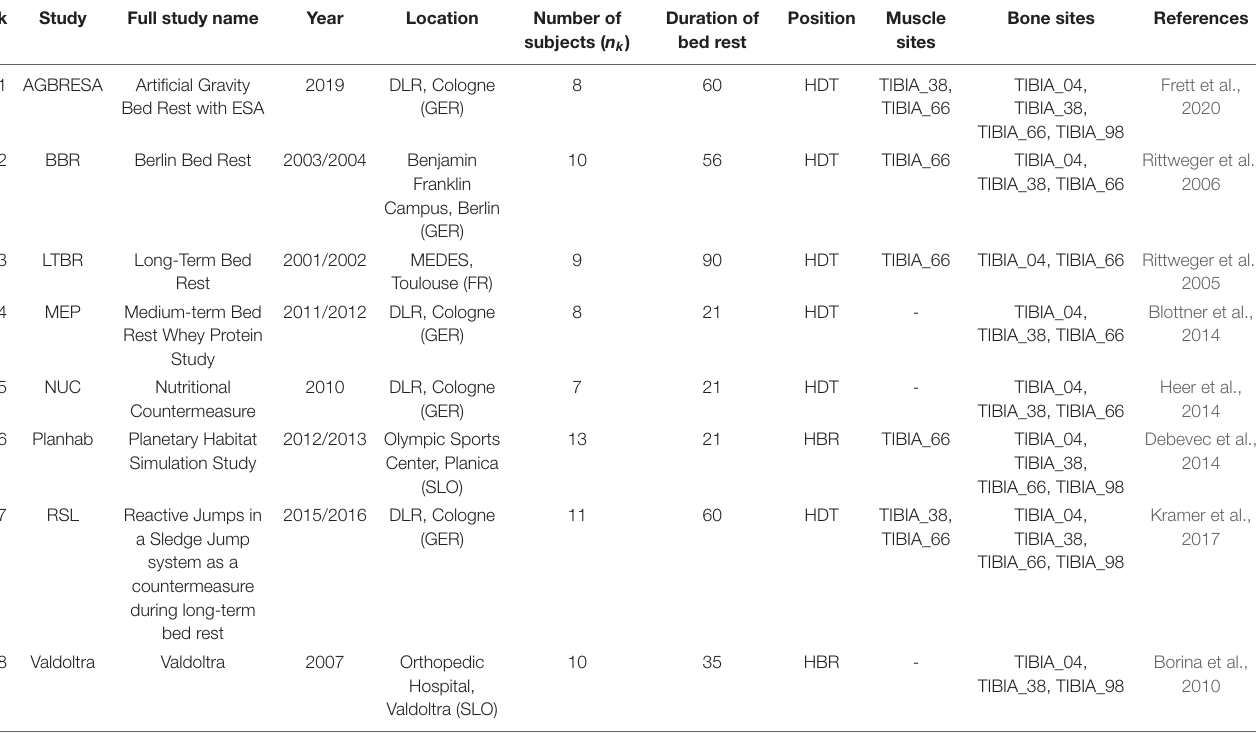
TABLE 1 | Overview about the included studies with information about the year, the location, the number of subjects, the duration of bed rest, bed rest position, and measurement